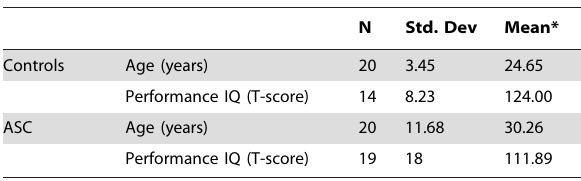
Table 1. Psychometric